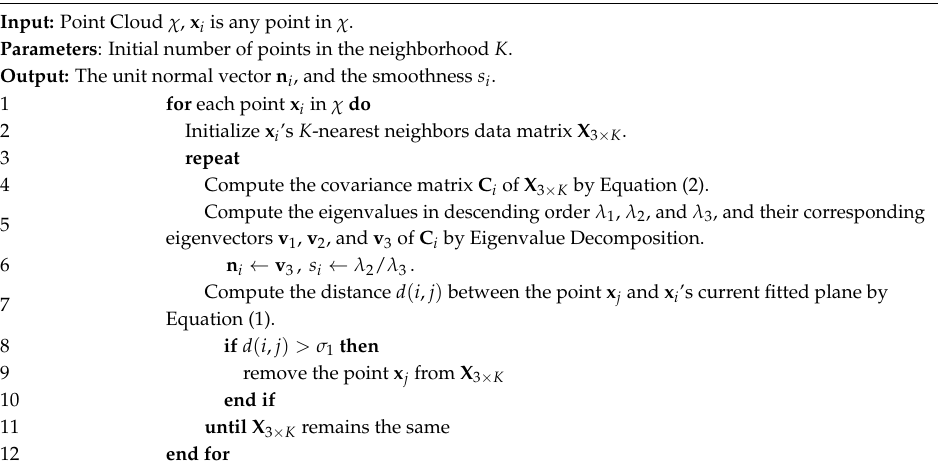
Algorithm 1 IPCA for computing the spatial characteristics of each